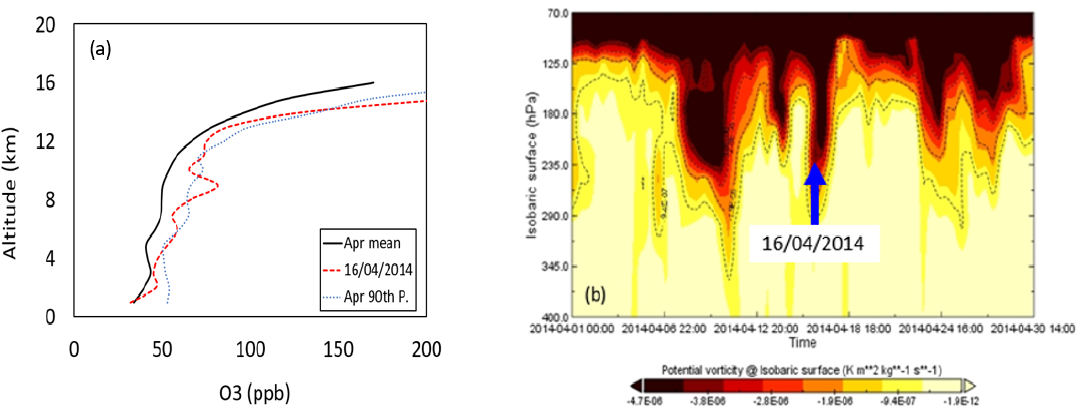
Figure 9. ( a ) Ozone troposphere profile over Irene on 16 April 2014. ( b ) Potential vorticity at Isobaric surface over Irene on July 2004 (from MERRA-2). Solid line in Figure 9a indicates monthly O 3 average composite, broken line indicates O 3 event and dotted line indicate 90 th percentile composite. Colours in Figure 9b indicates the level of potential vorticity, black indicates high potential vorticity of more than 3 Km −2 kg −1 s −1 while yellow indicates potential vorticity of less than 2 Km −2 kg −1 s −1 . Blue arrow in Figure 9b indicates the event that is associated with O 3 profile in Figure 9a.